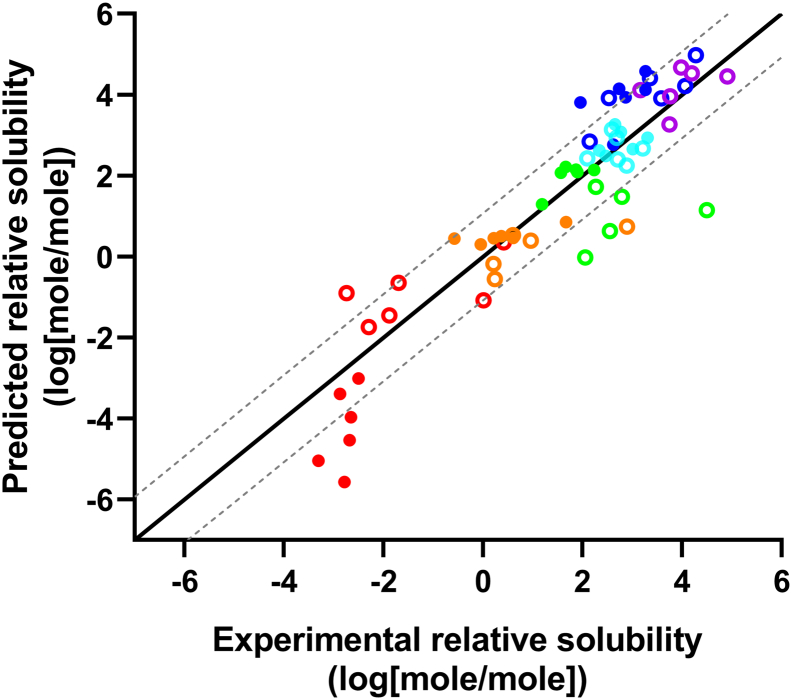
The experimental solubility and COSMO-RS predicted solubility in DES relative to water (* or ethanol). The black solid line illustrates the ideal fit and the grey dotted line represents the expected 0.95 confidence interval of the computational predictions. Slope of best linear fit = 1.07, intercept = −0.18, R2 = 0.82, RMSE = 1.042. Image 26Aprepitant*, Image 27celecoxib, Image 28cinnarizine, Image 29flufenamic acid, Image 30ibuprofen, Image 31indomethacin, Image 32lidocaine, Image 33naproxen, Image 34paracetamol, Image 35probucol*, and Image 36theophylline.